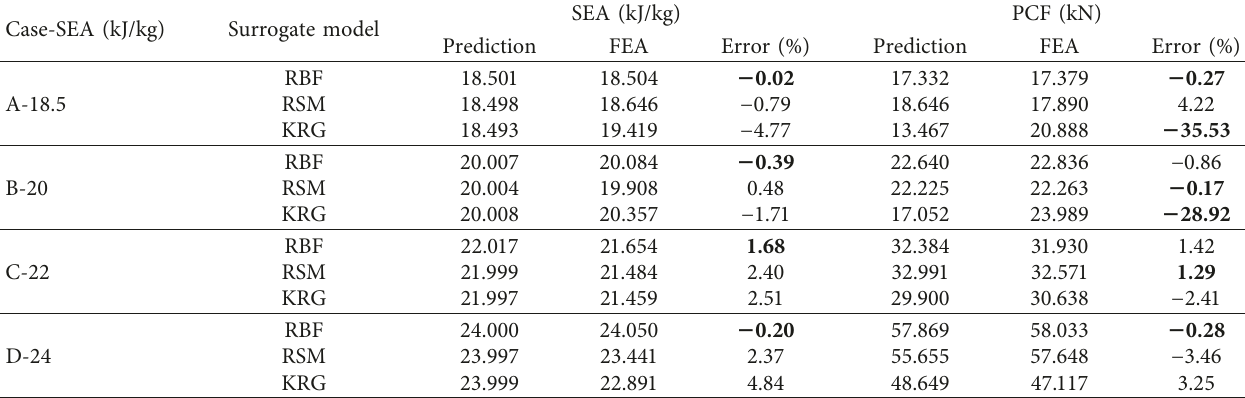
Table 4: Optimal solution under four cases.